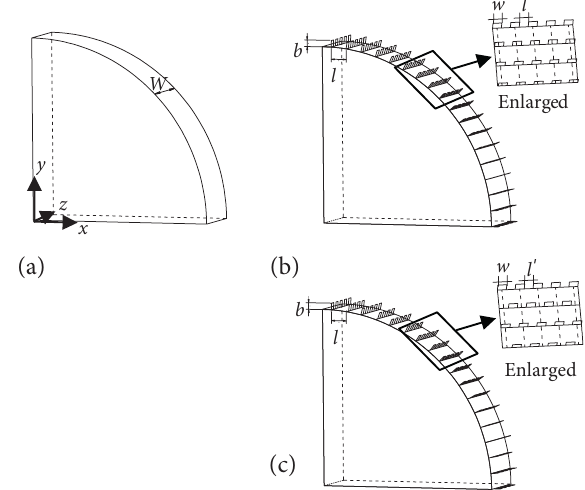
Fig. 2. Test dam with: (a) smooth spillway; (b) parallel flashboard spillway; (c) interlaced flashboard spillway